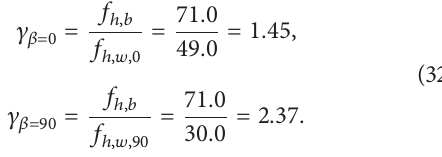
Table 5: Experimental and analytical shear capacities for the fastener in the uplift tests (loading parallel to grain). Number of Uplift Screws